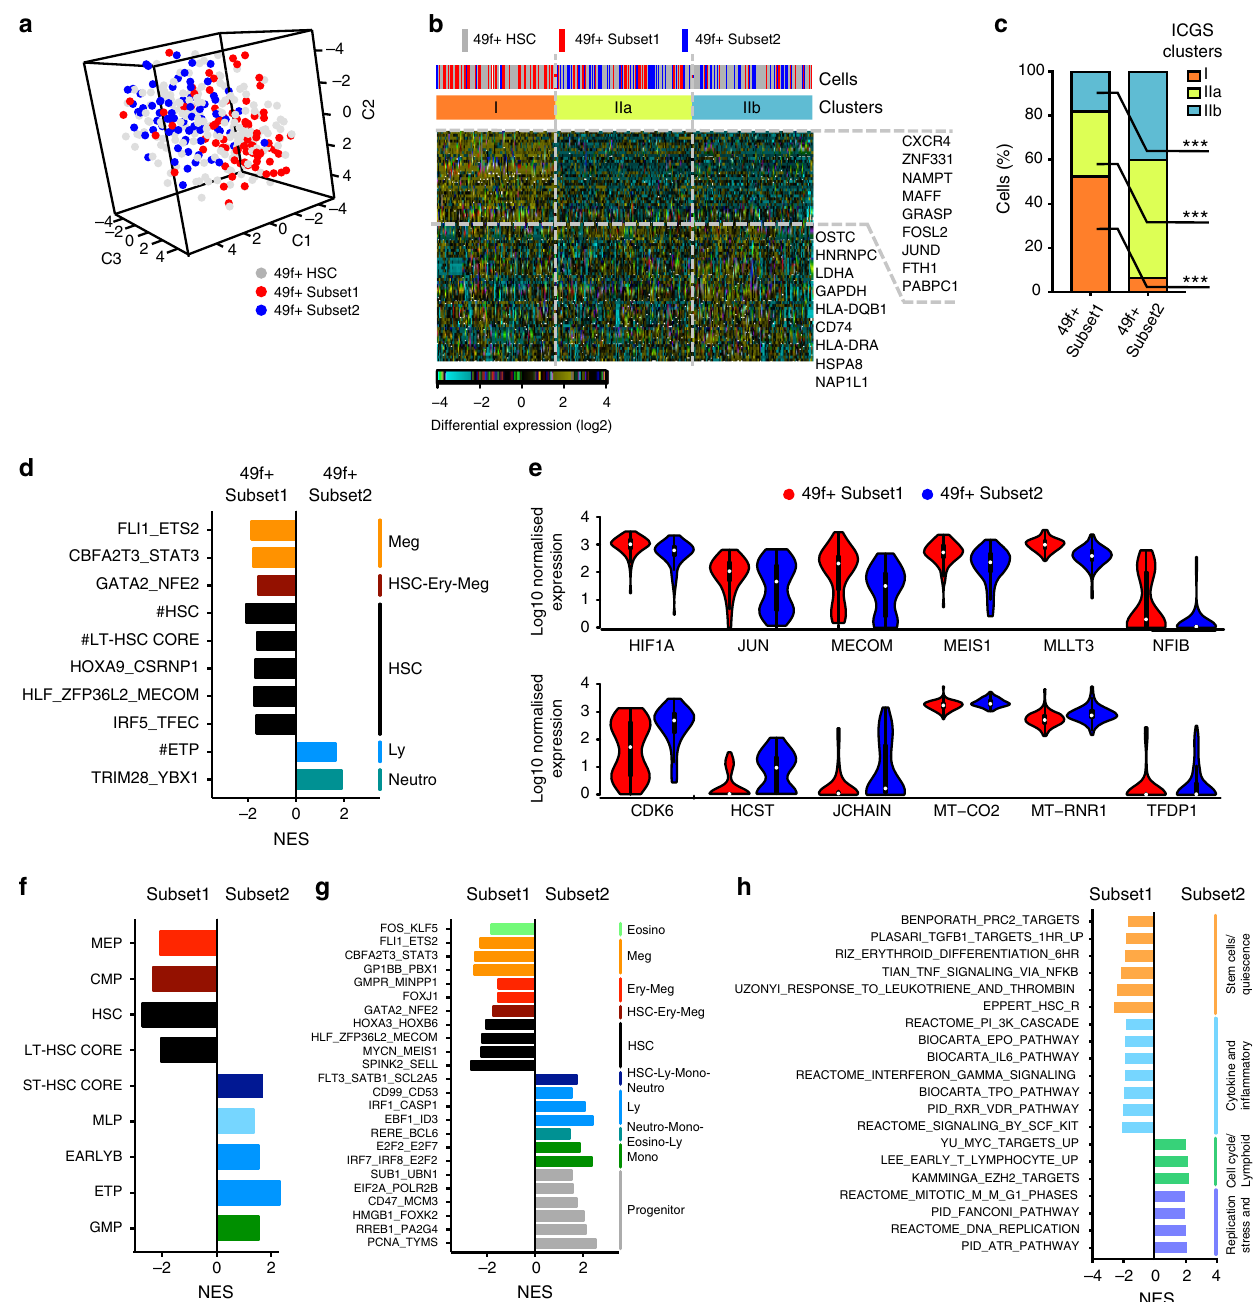
Fig. 3 Polarisation of transcriptional pro fi les and establishment of lineage-priming programmes in the 49f + HSC compartment. a – e Single-cell RNA-seq analysis of 49f + HSCs ( n = 169), 49f + Subset1 ( n = 78) and 49f + Subset2 ( n = 75) single cells. a tSNE representation of single 49f + HSCs (grey), 49f + Subset1 (red) and 49f + Subset2 (blue) cells. All tSNE analyses were performed on highly variable genes (2420 genes computed as in ref. 58 ). b , c ICGS analysis. b Heatmap of expression of guide genes selected by ICGS. Genes are represented in rows, with selected genes annotated on the side. Columns represent single cells, the phenotype of which is indicated by the uppermost bar of the top panel. Bottom bar of the top panel shows major clusters identi fi ed by ICGS. c Percentage of 49f + Subset1 and 49f + Subset2 single cells found in the indicated ICGS clusters; *** p < 0.001 by two-tailed Fisher test. d Population-speci fi c signatures from 32 , and lineage-priming gene modules derived from 18 signi fi cantly enriched (Benjamini-Hochberg adjusted p -value < 0.05 by pre-ranked GSEA) in 49f + Subset1 and 49f + Subset2 cells. e Log 10 normalised expression of selected genes differentially expressed between 49f + Subset1 (red) and 49f + Subset2 (blue) cells (FDR < 0.05 by DESeq2). f – h 20-cell RNA-seq of Subset1 and Subset2. Signi fi cantly enriched (Benjamini- Hochberg adjusted p -value < 0.05 by pre-ranked GSEA) population-speci fi c signatures from 32 ( f ), lineage-priming gene modules derived from 18 ( g ), and gene ontology terms and MSigDB genesets ( h ) in Subset1 and Subset2 cells. NES normalised enrichment